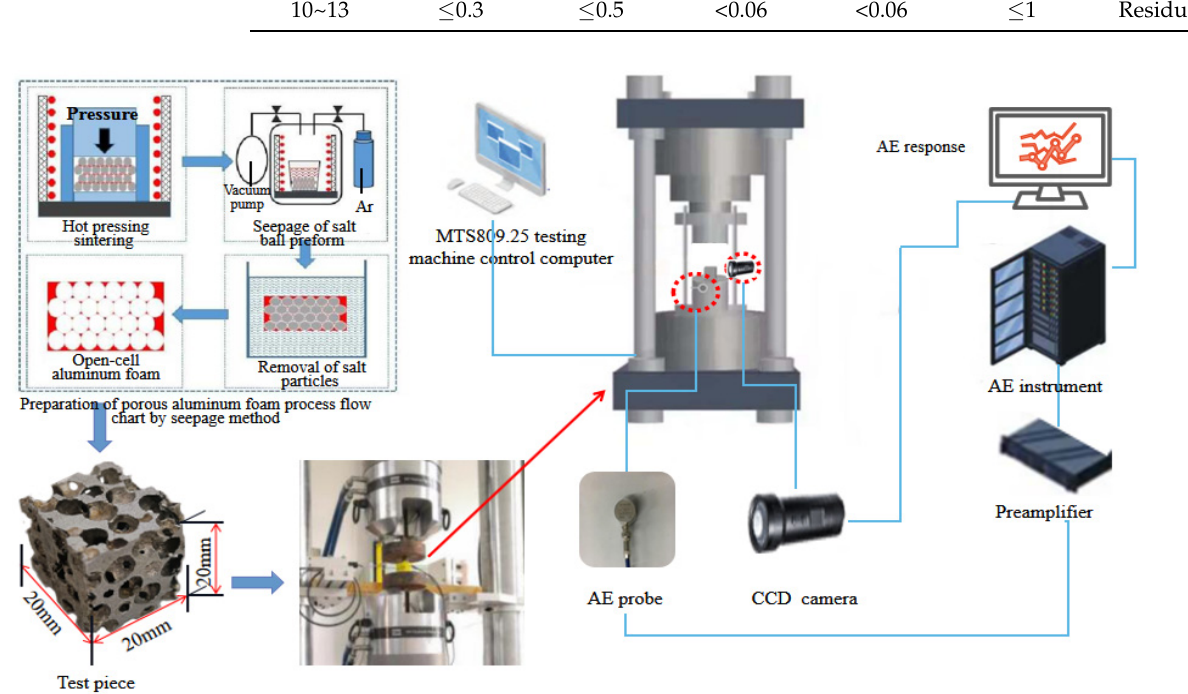
Figure 1. Experimental process.